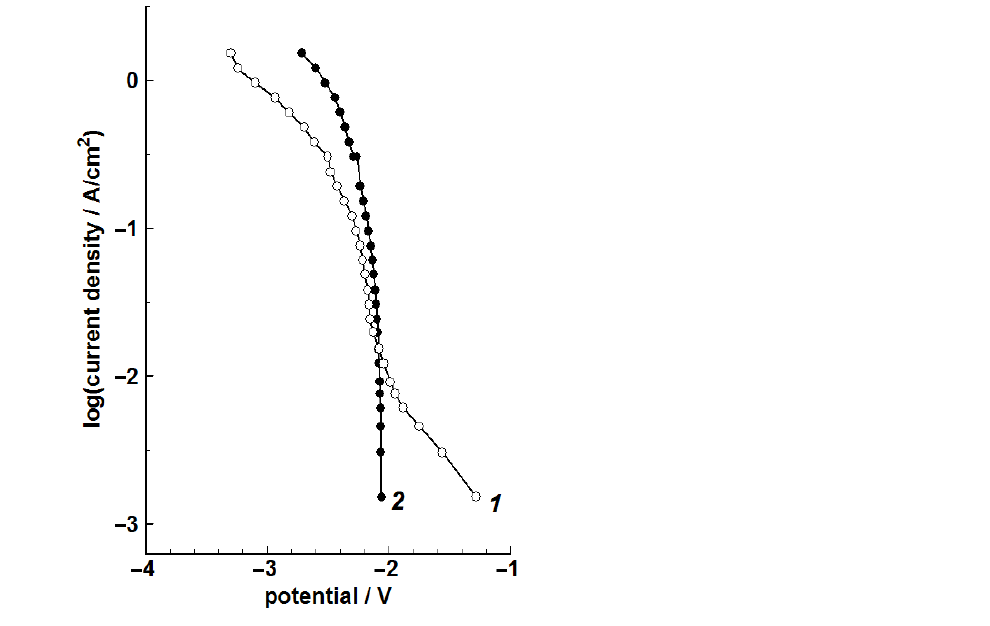
Figure 5. Cathodic polarization curves of tungsten electrode in 3LiCl–2KCl eutectic based melts containing 5.47 wt. % ZrCl 4 at 544 °C (1) and 637 °C (2). Potentials vs. 2Cl − /Cl 2 reference couple.